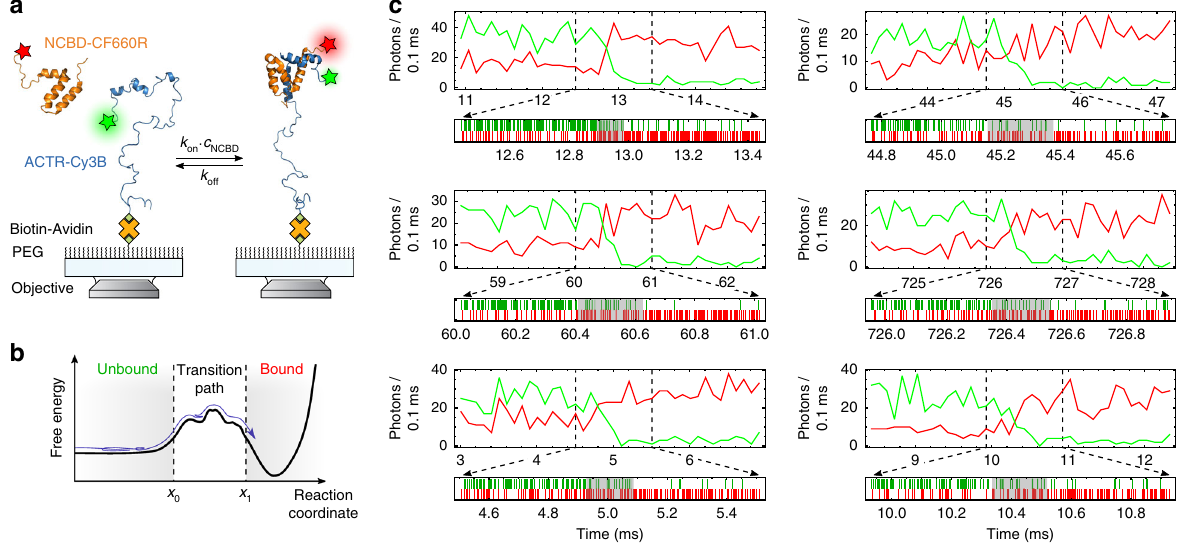
Fig. 1 Observing coupled folding and binding by single-molecule FRET. a ACTR labeled with Cy3B as the donor fl uorophore (green) is immobilized on a polyethyleneglycol (PEG)-coated quartz cover slide via a biotin − avidin − biotin linkage and excited by a laser beam. NCBD free in solution is labeled with CF660R as the acceptor fl uorophore (red). Cartoon based on PDB entries 1KBH 15 and 2KKJ 17 . b Schematic free-energy landscape of the reaction with a molecular trajectory of a binding transition. The molecules are in the unbound or bound states most of the time and only rarely cross the energy barrier. A binding transition path extends from the time when x 0 is crossed until x 1 is reached without returning to x 0 . c Examples of measured fl uorescence time traces of binding events (ionic strength 108 mM, viscosity 1.28 cP), represented as binned (top) and single-photon data (bottom). The molecules start in the unbound state, indicated by high donor intensity (green) and low acceptor intensity (red). When NCBD binds to ACTR, the FRET ef fi ciency increases in a rapid jump, corresponding to the transition path, with a concomitant increase in acceptor emission and a decrease in donor emission. In the single-photon representation of the transition-path region, donor photons are shown as green lines and acceptor photons as red lines. Segments of the trajectories identi fi ed as populating the transition path by the Viterbi algorithm are indicated by the gray shading in the single-photon time